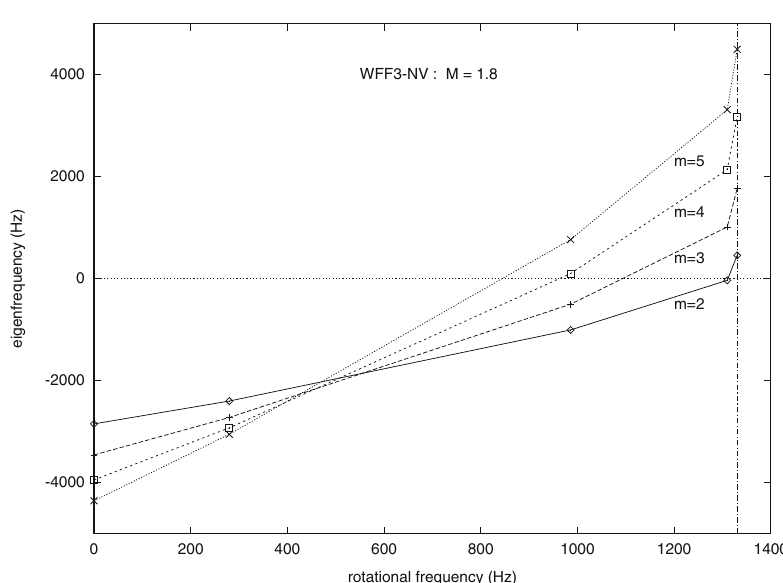
Fig. 12 Eigenfrequencies (in the Cowling approximation) of f -modes along a M = 1 . 8 M (cid:3) sequence of models, constructed with the WFF3-NV EOS. The vertical line corresponds to the frequency of rotation of the model at the mass-shedding limit of the sequence. (Image reproduced with permission from Yoshida and Eriguchi 1999, copyright by AAS)